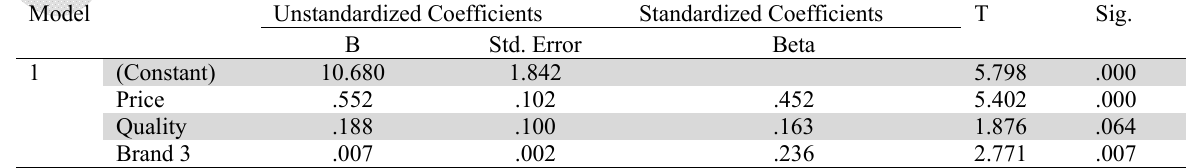
Multiple Linear Regression Test Results (Coefficients a ) Model Unstandardized Coefficients Standardized